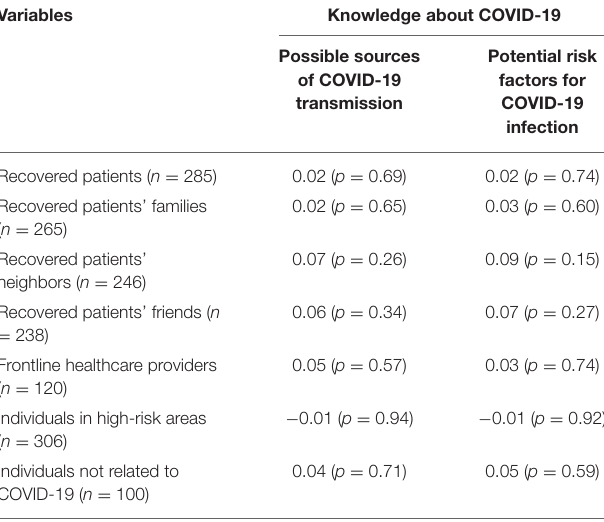
TABLE 6 | Correlations between the knowledge about COVID-19 and the COVID-19-related stigma (stigma score > 3). Variables